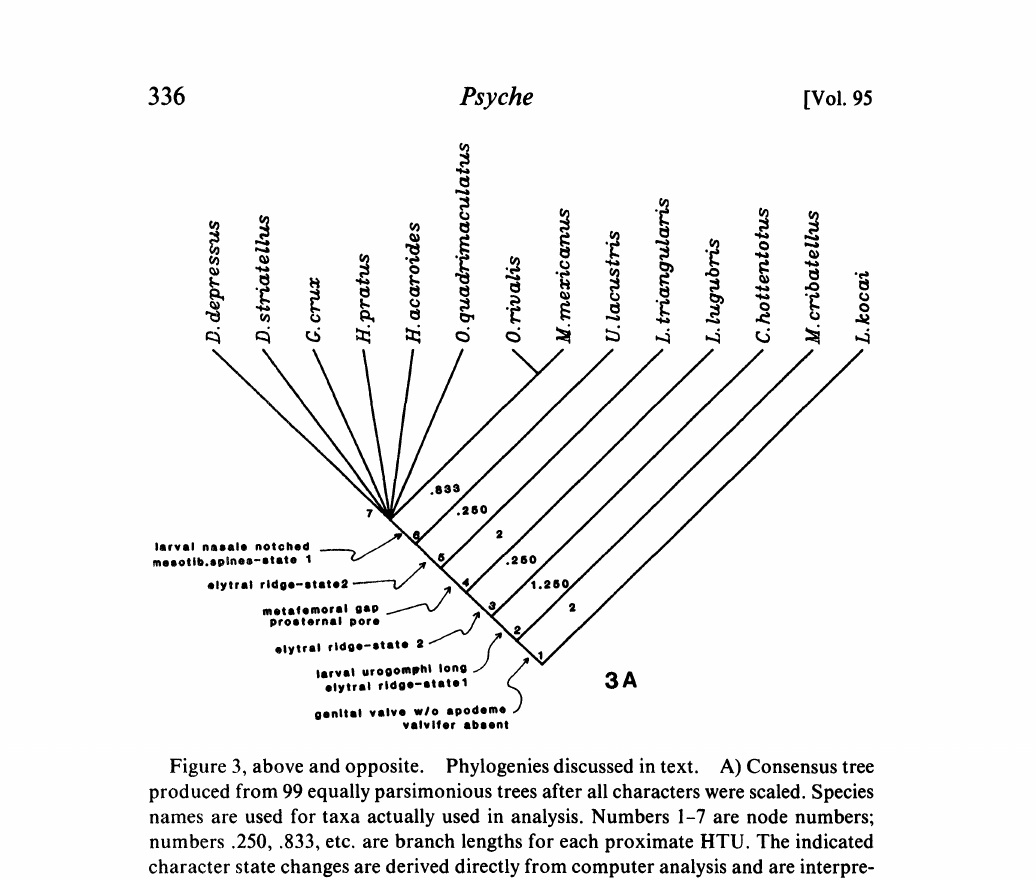
Figure 3, above and opposite. Phylogenies discussed in text. A) Consensus tree produced from 99 equally parsimonious trees after all characters were scaled. Species names are used for taxa actually used in analysis. Numbers 1-7 are node numbers; numbers .250, .833, etc. are branch lengths for each proximate HTU. The indicated character state changes are derived directly from computer analysis and are interpre- ted/evaluated in text. B) and C) More conservative phylogenetic hypotheses. See text for discussion. Generic and tribal names are used in place of species